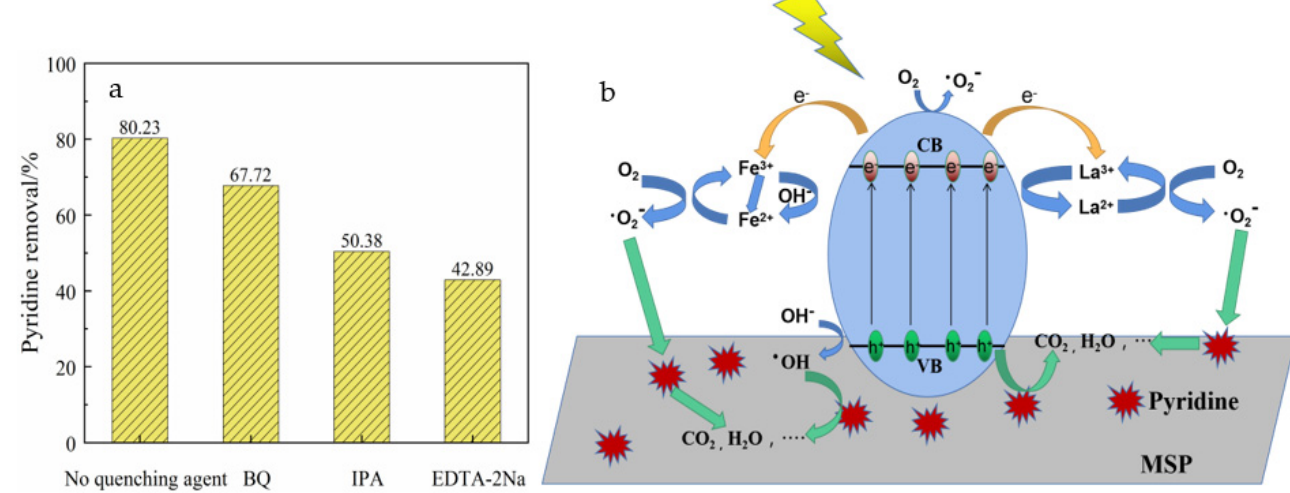
Figure 9. ( a ) Effects of different scavengers on photocatalytic degradation of pyridine and ( b ) pro- posed mechanism for pyridine photodegradation process using La − Fe − TiO 2 @MSP.